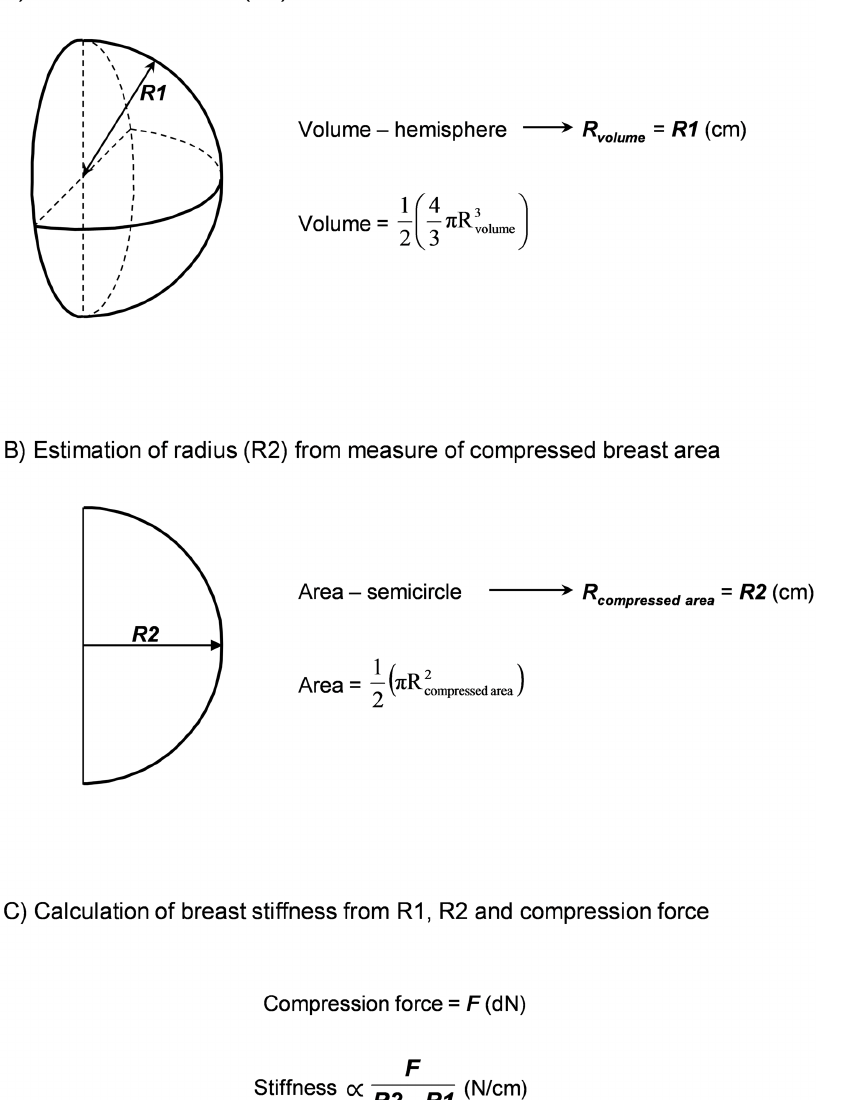
Figure 1. Estimation of breast stiffness. A. Estimation of radius (R1) from measure of breast volume B. Estimation of radius (R2) from measure of compressed breast area C. Calculation of breast stiffness from R1, R2 and compression